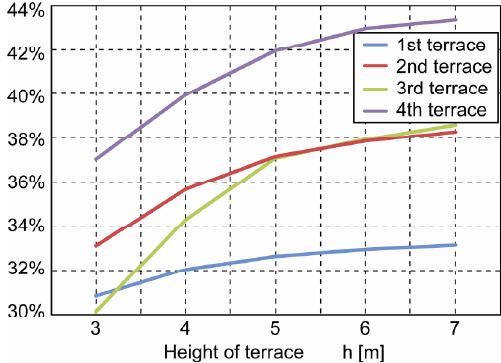
Fig. 23. Trend of change of effect of cutting depth s